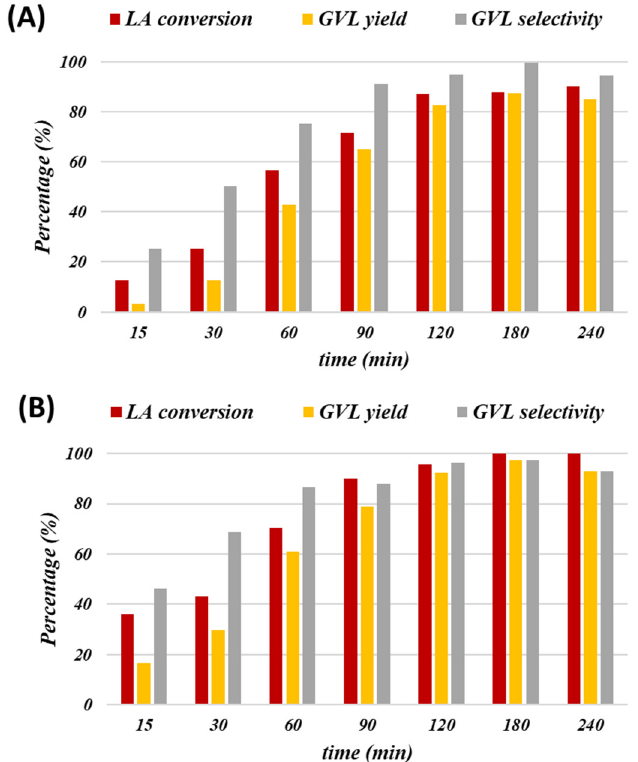
Figure 4. Time effect for levulinic acid HDO to GVL over ( A ) Ru/AC, ( B ) Ru/C H Zn cotton catalysts. Reaction conditions: 100 ◦ C, 10 mL of H 2 O, (LA) 0.5 M, 10 mg of catalyst, 10 bar P H2